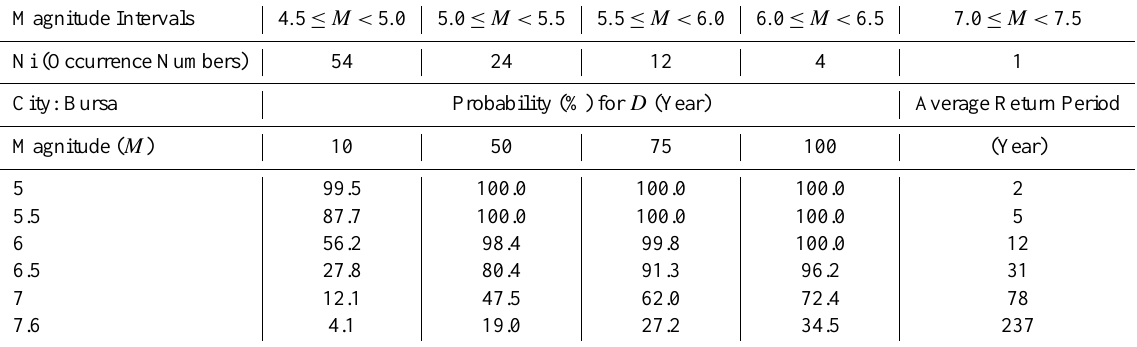
Table 3e. Earthquake occurrence probability (%) for D (Year) for Bursa city. Magnitude